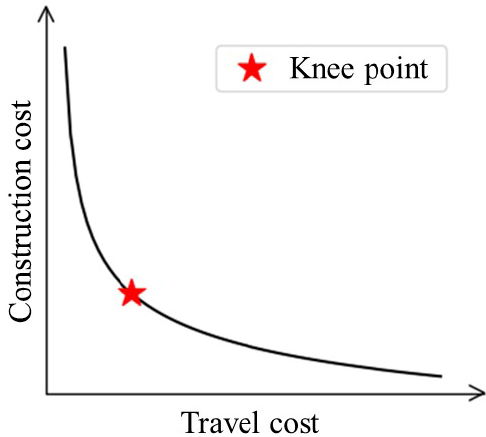
Figure 4. Geometric expression of the knee point.